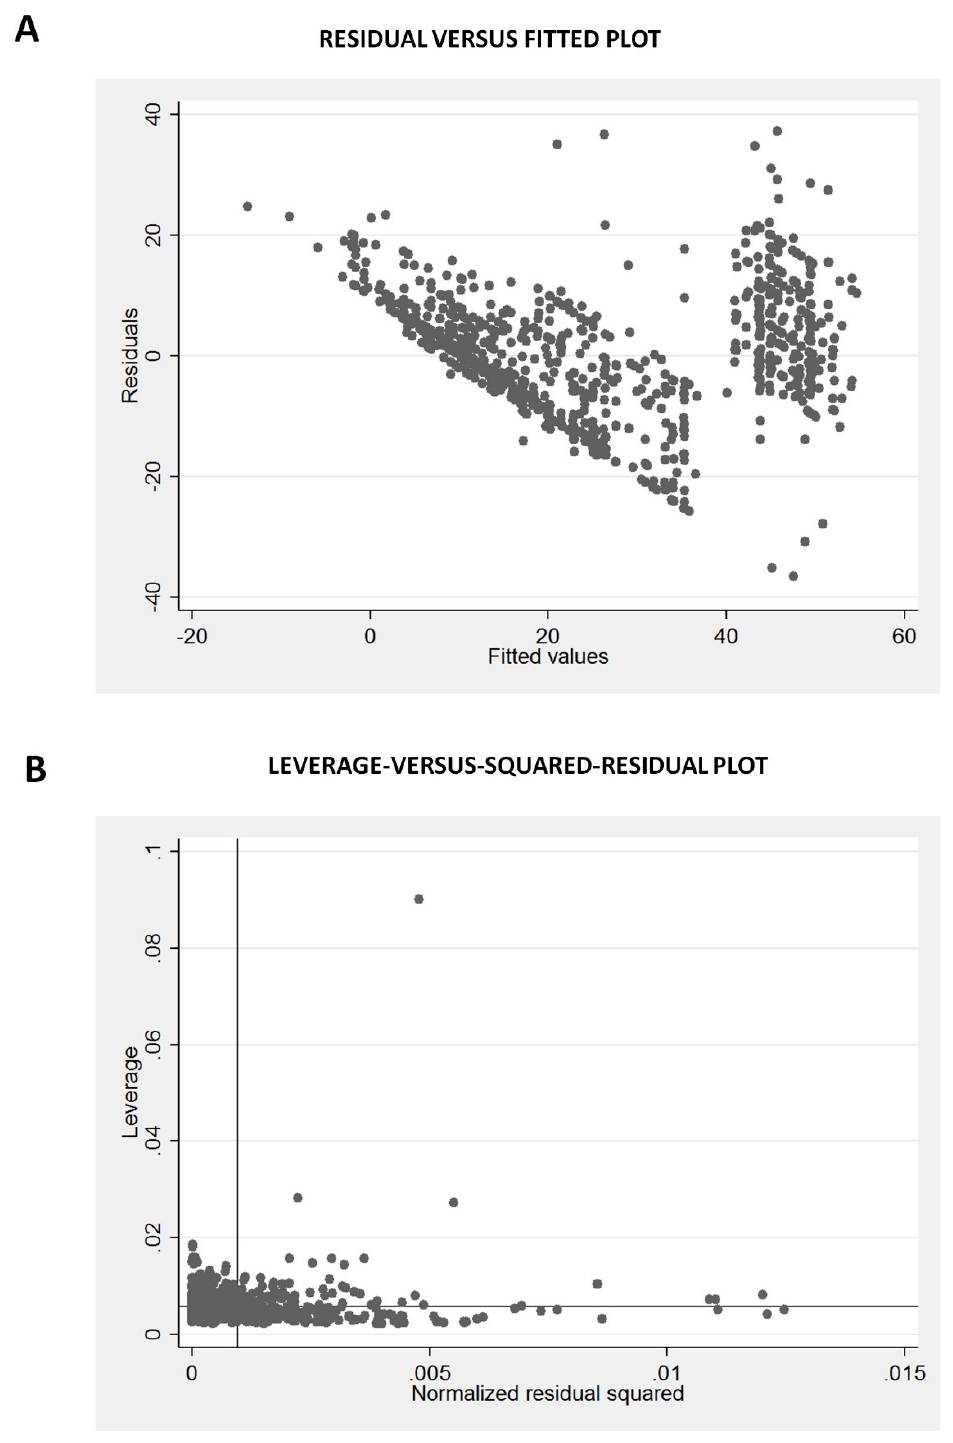
Figure 3. Graphs showing the residual versus fitted plot ( A ) and the leverage versus squared residual plot ( B ).